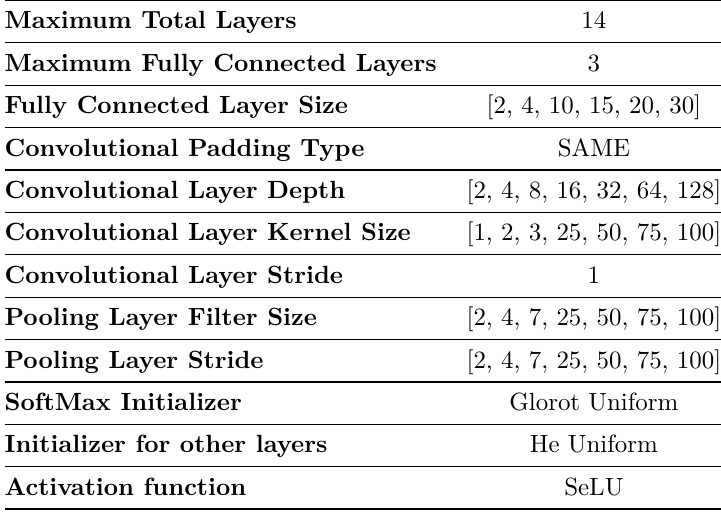
Table 1: Hyperparameters for the neural network generation and hyperparameter options for the generated neural networks used for all